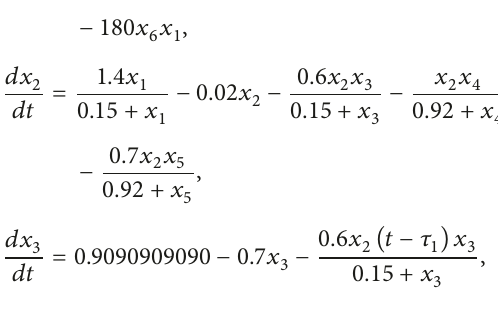
𝑥 = 1.2, 𝑥 1 = 0, 𝑥 = 0 , and 𝑆 = 3, 𝑘 7 8